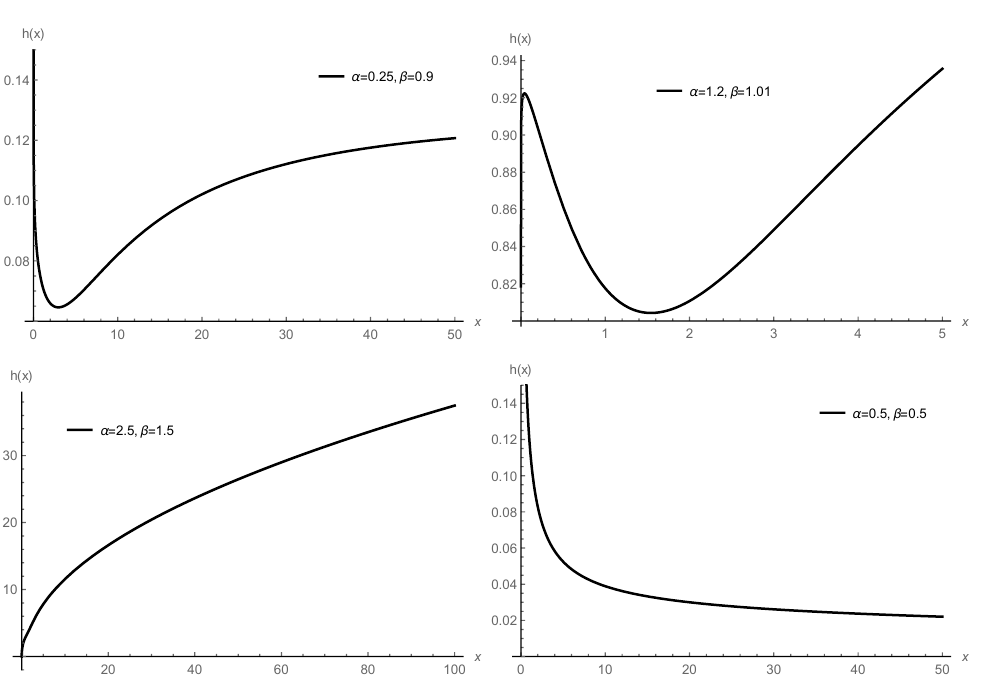
Figure 2. Plots of the H r F of the PHD with various parametric